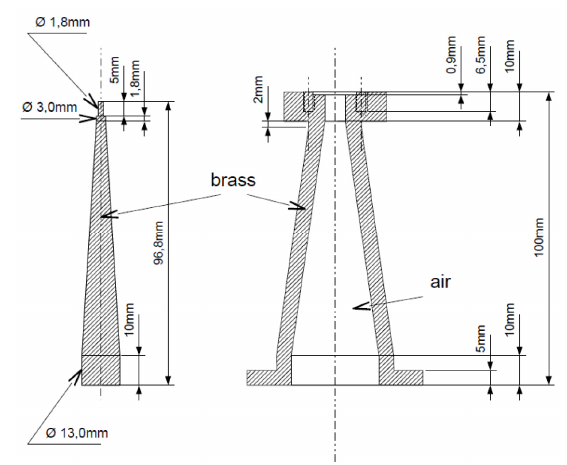
Figure 2. Design of the inner core (left) and metallic shield (right).